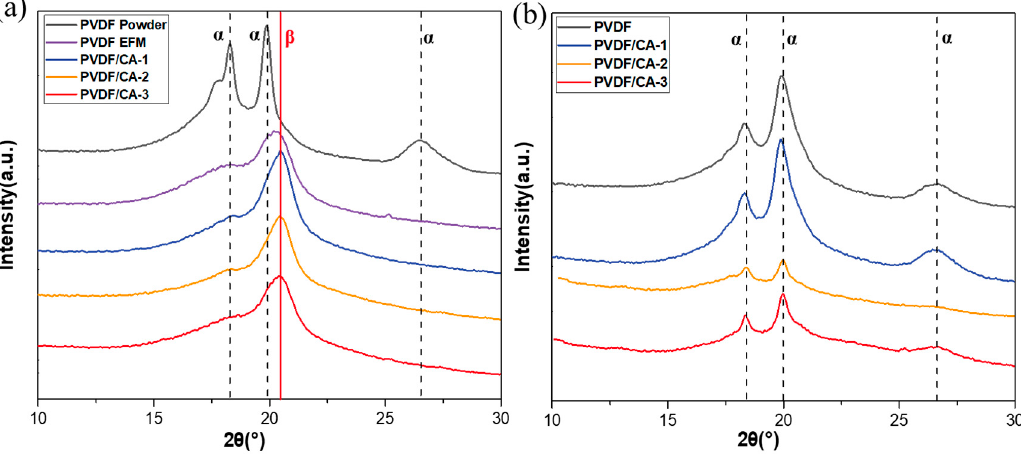
Figure 4. XRD analysis of ( a ) PVDF/CA EFMs and PVDF powder, and ( b ) PVDF/CA cast